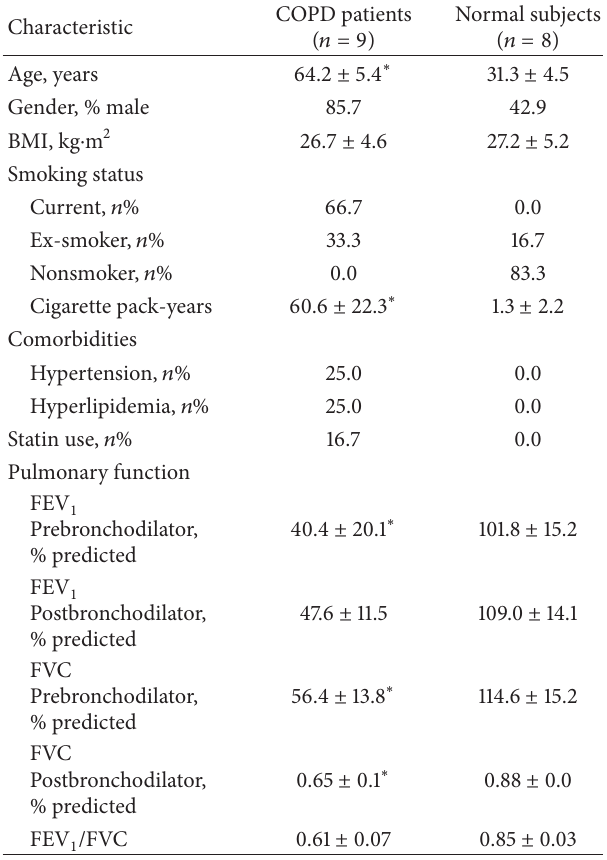
Table 1: Subject characteristics of COPD patients and normal